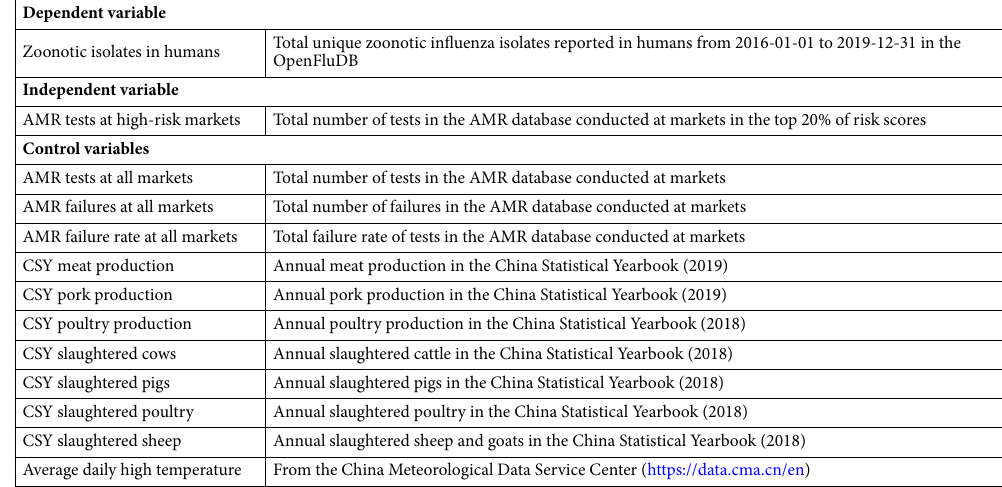
Table 1. Predicting zoonotic outbreaks—dependent, independent, and control variables. The China Statistical Yearbook data is taken from the last available year (http:// www. stats. gov. cn/ engli sh/).